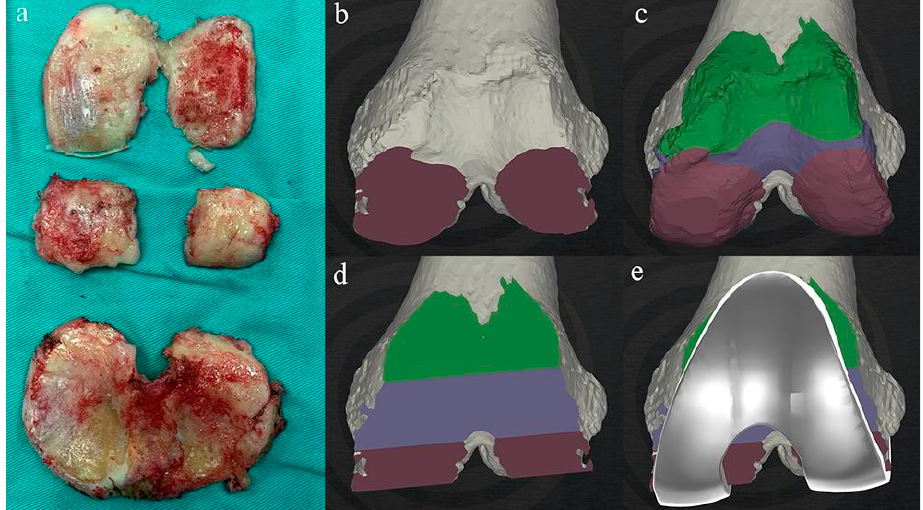
Figure 3. Intraoperative verification of bone resection. The geometry and thickness of resected bone fragments ( a ) were used to compare the shape of bone cut surface ( b , d ), the geometry of virtual bone cut fragments ( c ), the thickness of component trials, and the coverage of the bone cut surface ( e ).